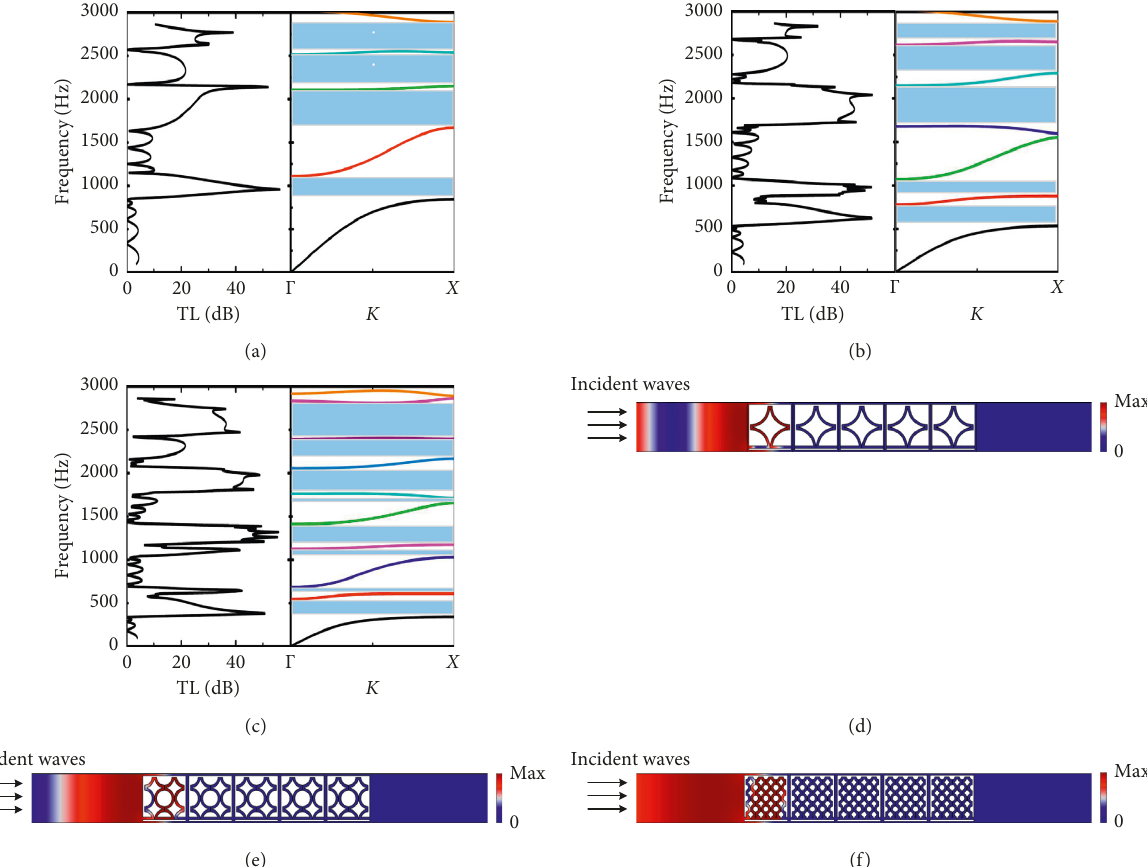
Figure 4: (a–c) Transmission losses of the fractal acoustic structures with five units, from the first order to third order. (d) Sound pressure field of the first order at 960 Hz. (e) Sound pressure field of the second order at 620 Hz. (f) Sound pressure field of the third order at 380